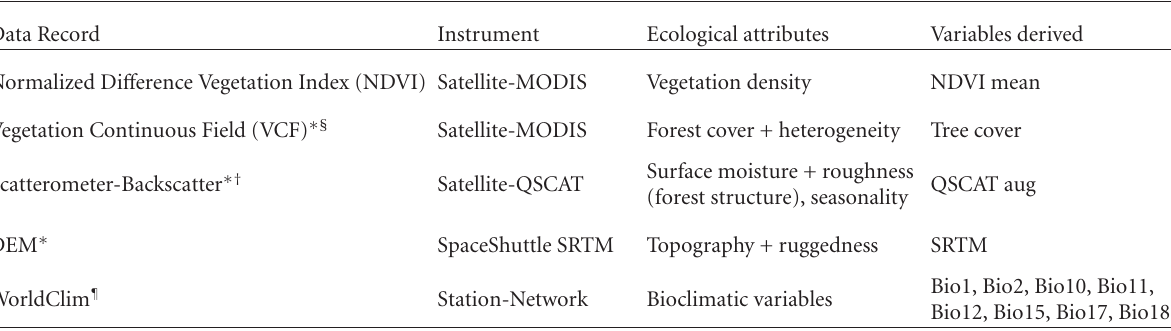
Table 3: List of environmental variables used in our